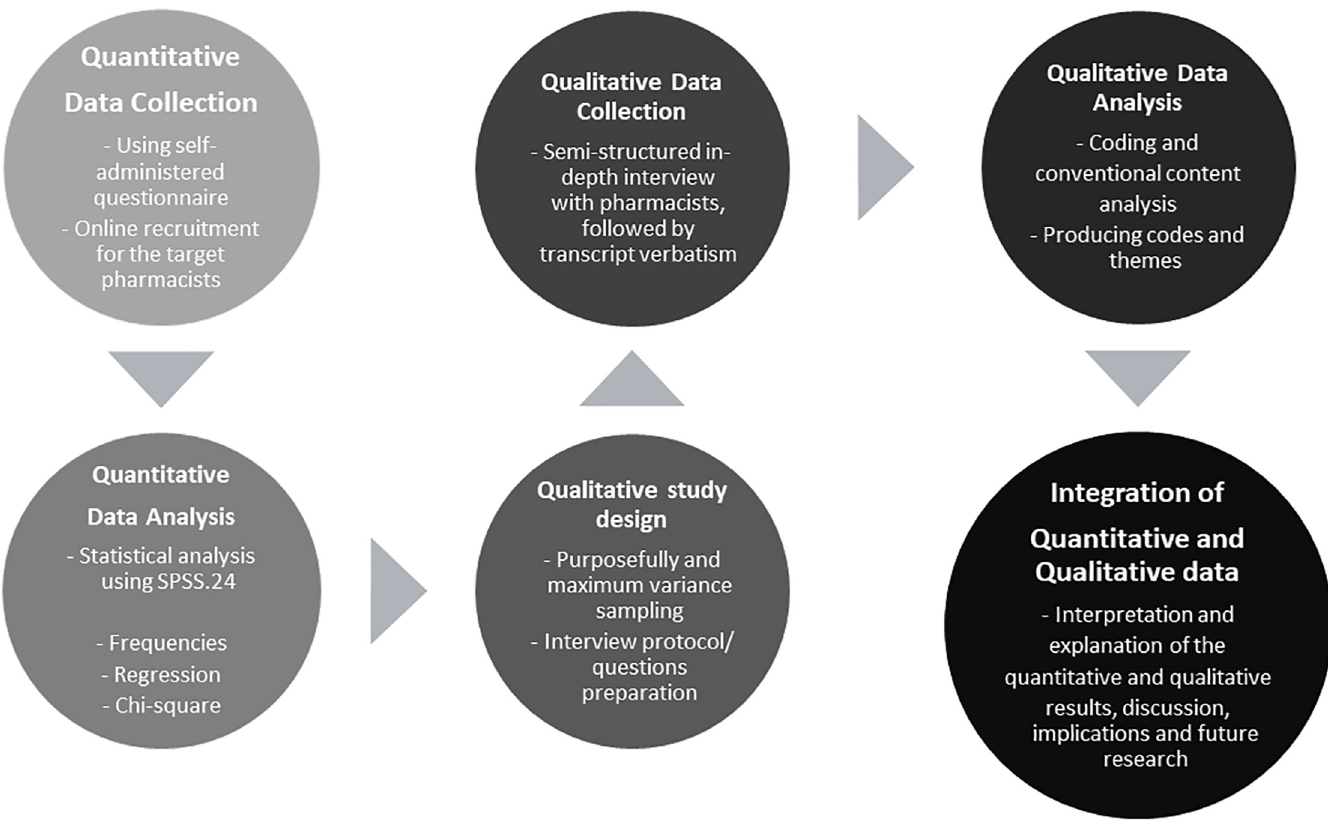
Fig 1. Descriptive scheme for the study mixed sequential